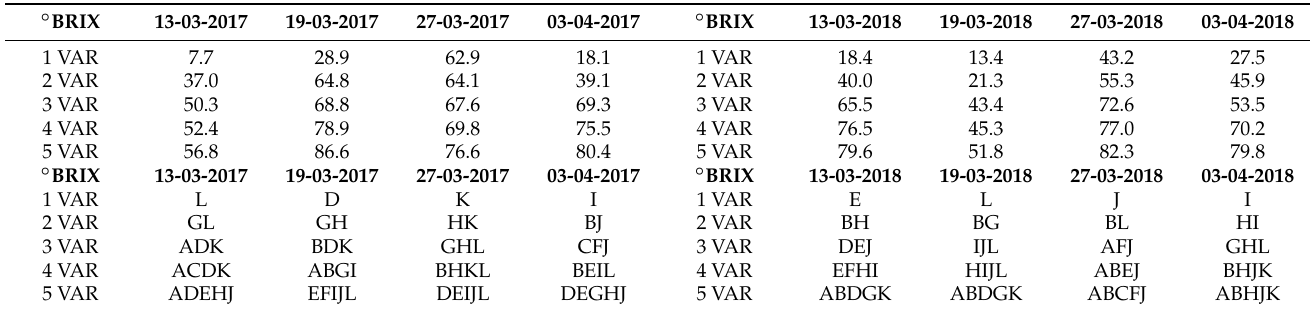
case of the 2017 season, the results are very homogeneous and with high coefficients, over 60% by the end of March and the beginning of April. Table 5. Summary of R 2 for ◦ Brix. R 2 obtained at each reporting date (upper) and the bands included in each one (lower). Band designation: A (B3); B (B4); C (B5); D (B6); E (B7); F (B8); G (B11); H (B12); I (Chlorophyll); J (GNDVI); K (NDMI); L (NDVI).